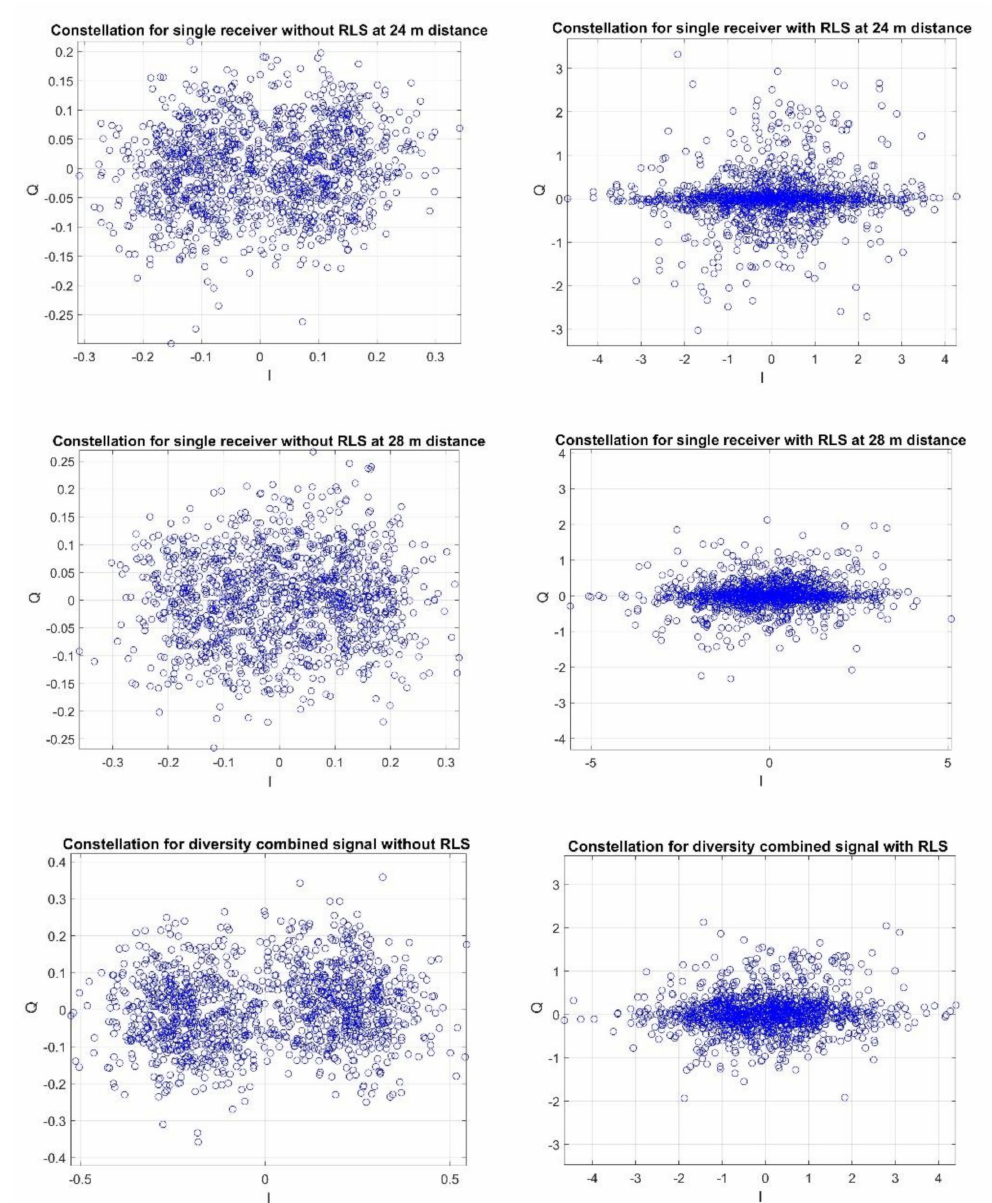
Figure 13. Example of a constellation for reception with hydrophones at the distance of 24 m and 28 m from the